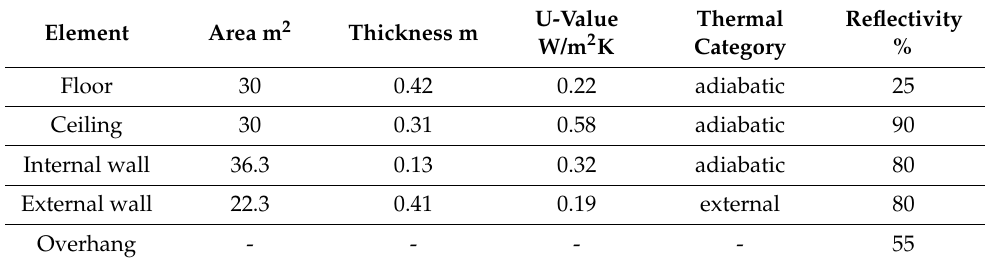
Table 2. Properties of the surfaces for energy simulation in TRNSYS.